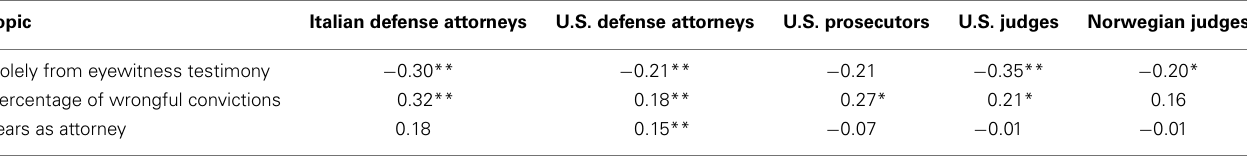
Table 2 | Correlations of the knowledge scale with other variables for various legal